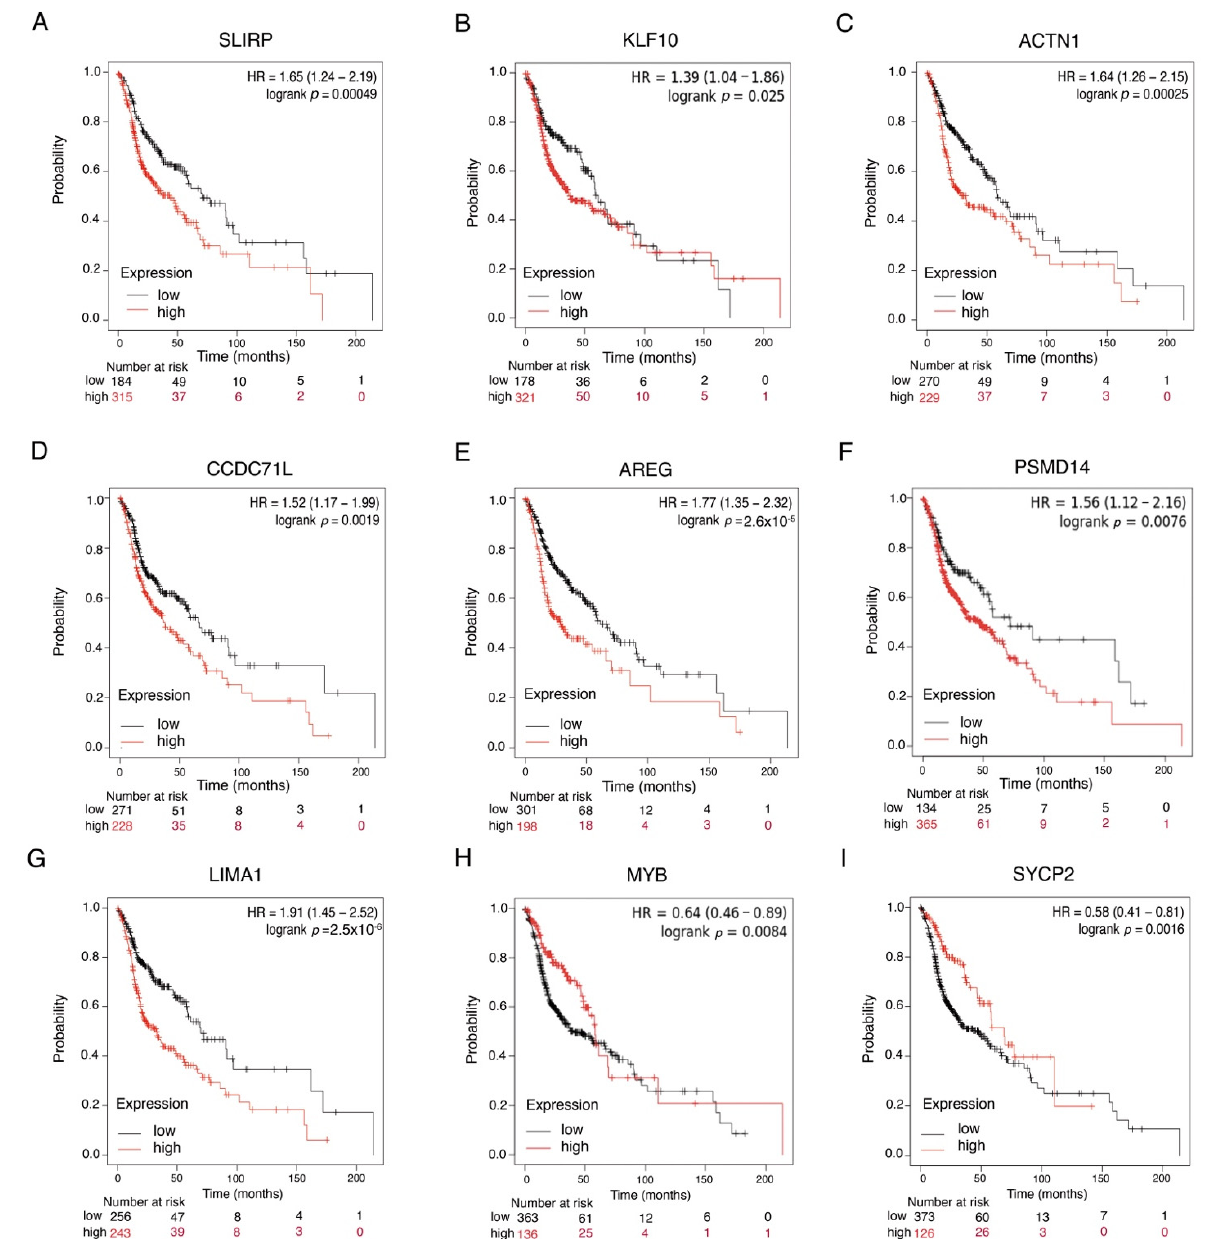
Figure 4. Differentially expressed mRNAs show clinical importance in patients with HNSCC. ( A – I ) Kaplan–Meier curves comparing global survival with respect to expression of DE SRLIP, KLF10, ACTN1, CCDC71L, AREG, PSMD14, LIMA1, MYB, and SYCP2 genes from patients with HNSCC. p values are shown in each graph. Survival data were analyzed with respect to database from Pan-cancer RNAseq Data.